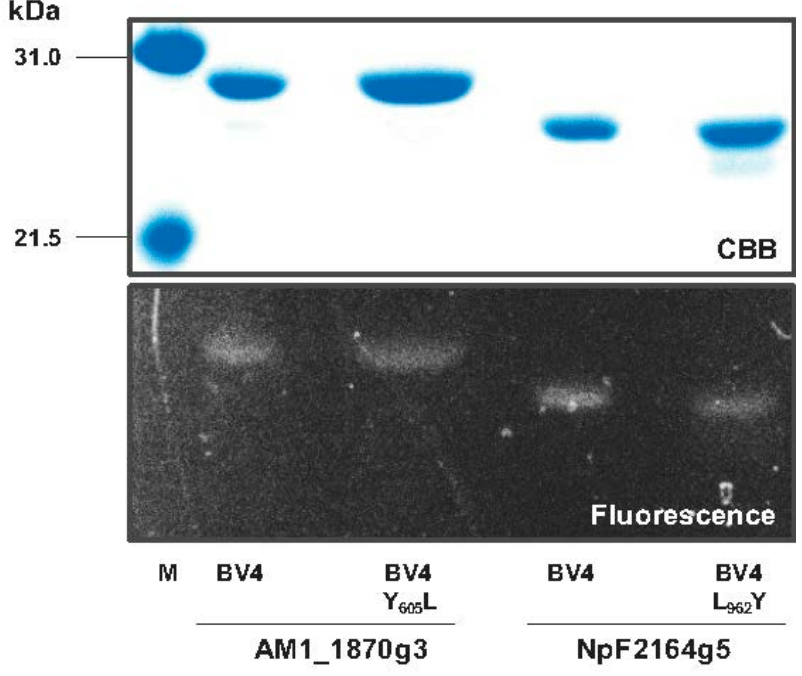
Figure 2. SDS-PAGE analyses of BV-bound AM1_1870g3_BV4, NpF2164g5_BV4, and their variants compared with marker proteins (M) ( upper panel, CBB stained; lower panel, fluorescence imaging).